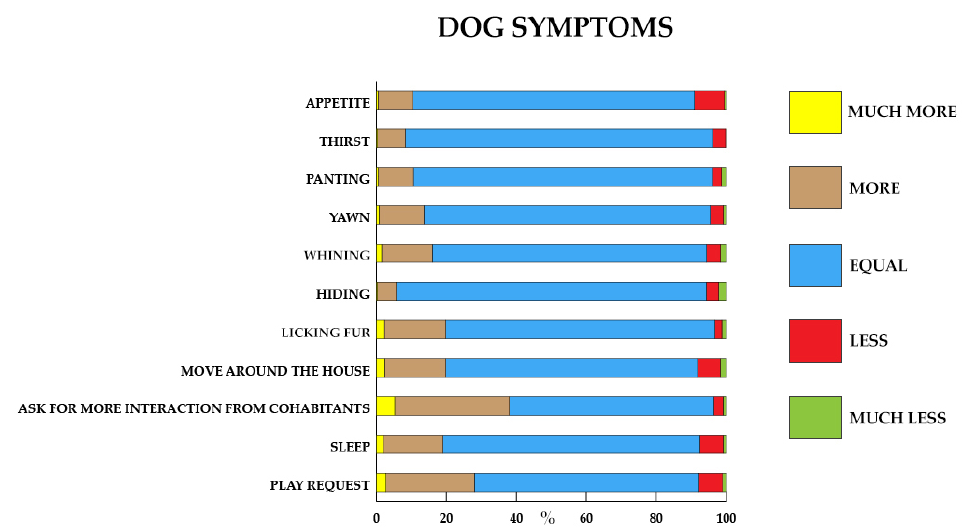
Figure 5. Clinical and behavioral symptoms manifested by the dog and reported by the owner. The answers included a comparison between the period before quarantine and the period of quarantine. The answers were “much more than before”, “more than before”, “equal to before”, “less than before”, and “much less than before”. Data are expressed in percentage.